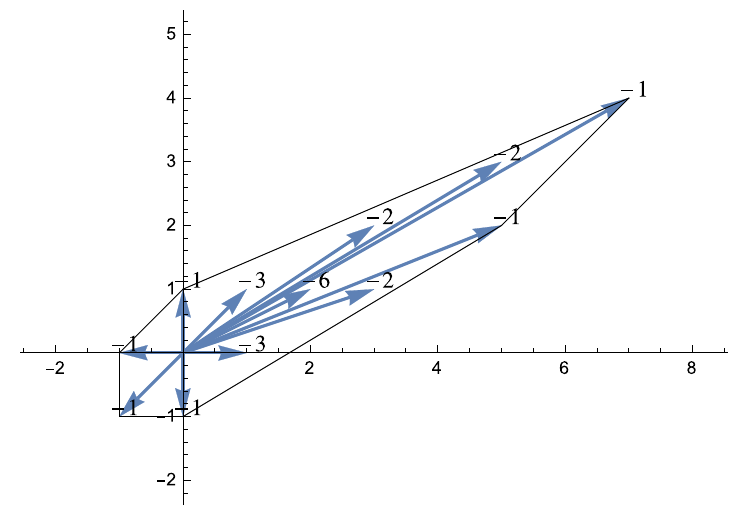
Figure 3. The toric fan of the base of a generic model with small h 1 ; 1 : f 23, 107, f -3, -2, -2, -1, -6, -1, -2, -3, -1, -1, -1, -1 gg . Each (cid:0) 1-curve in the base corresponds to a vertex of r